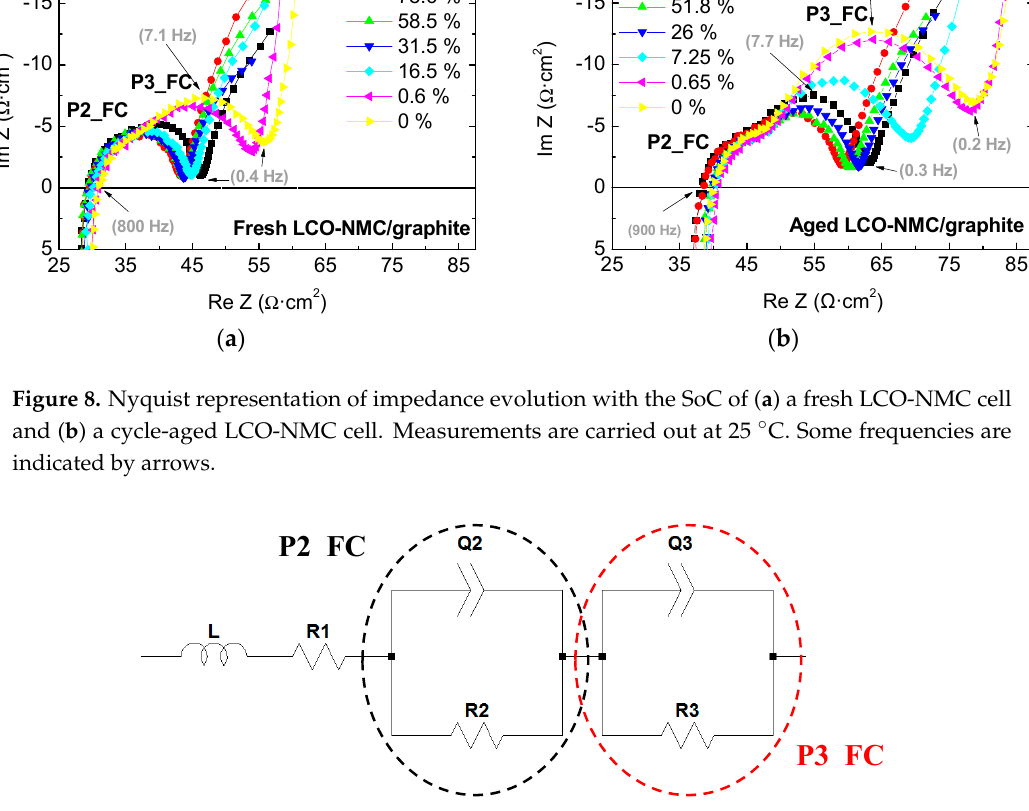
Figure 9. Electrical model employed to fit the impedance spectra of the full-cell